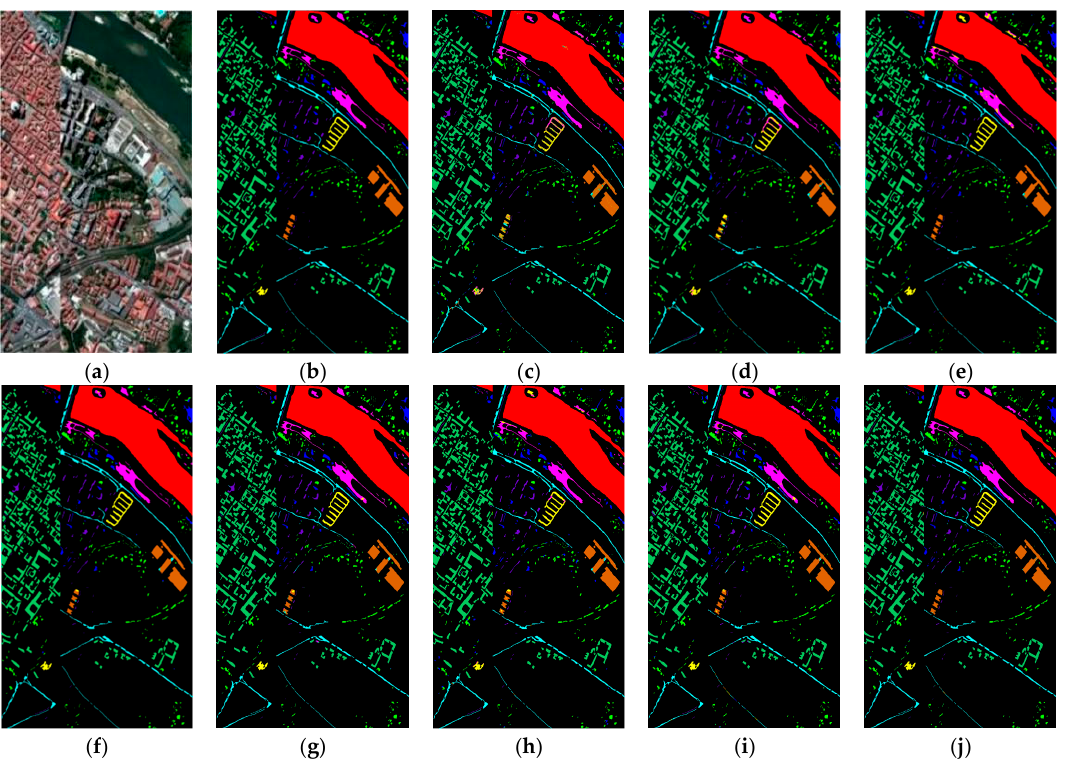
Figure 7. The classification map of Pavia Center. ( a ) False ‐ color image; ( b ) ground truth; ( c ) SVM;